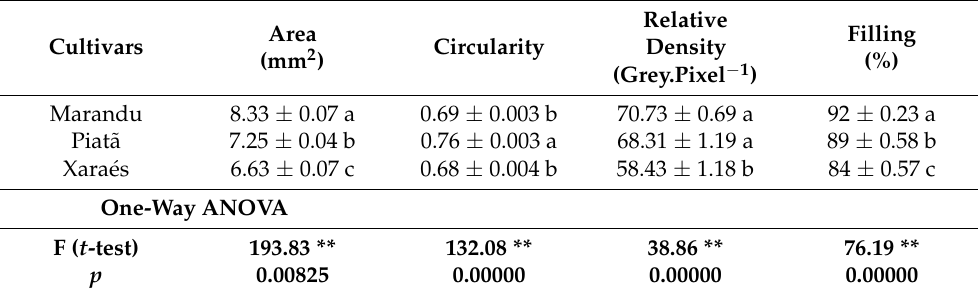
Table 1. Physical parameters evaluated from X-ray images of Brachiaria seeds, Marandu, Piat ã , and Xara é s cultivars, using the ImageJ program.